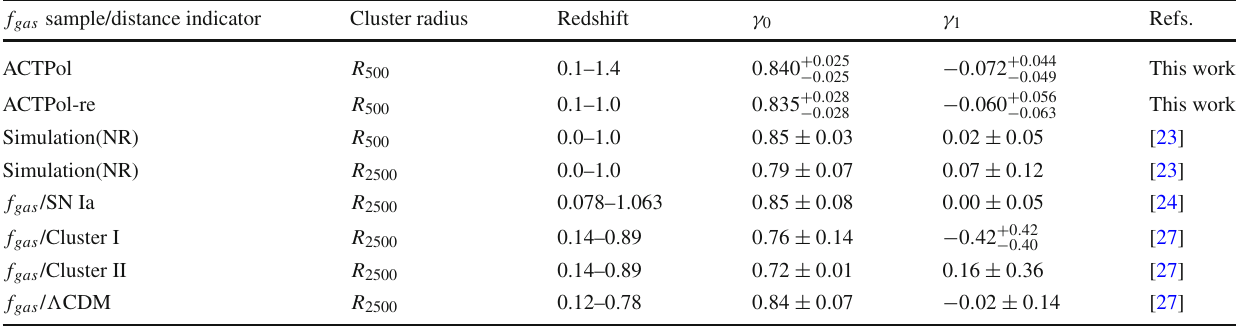
In the previous works, the luminosity distances/angular diameter dis- tances are derived from recent SN Ia observations, SZ effect/X-ray measurements of Cluster I [13] and Cluster II [14], or in the framework of Planck’s best-fitted (cid:4) CDM cosmology